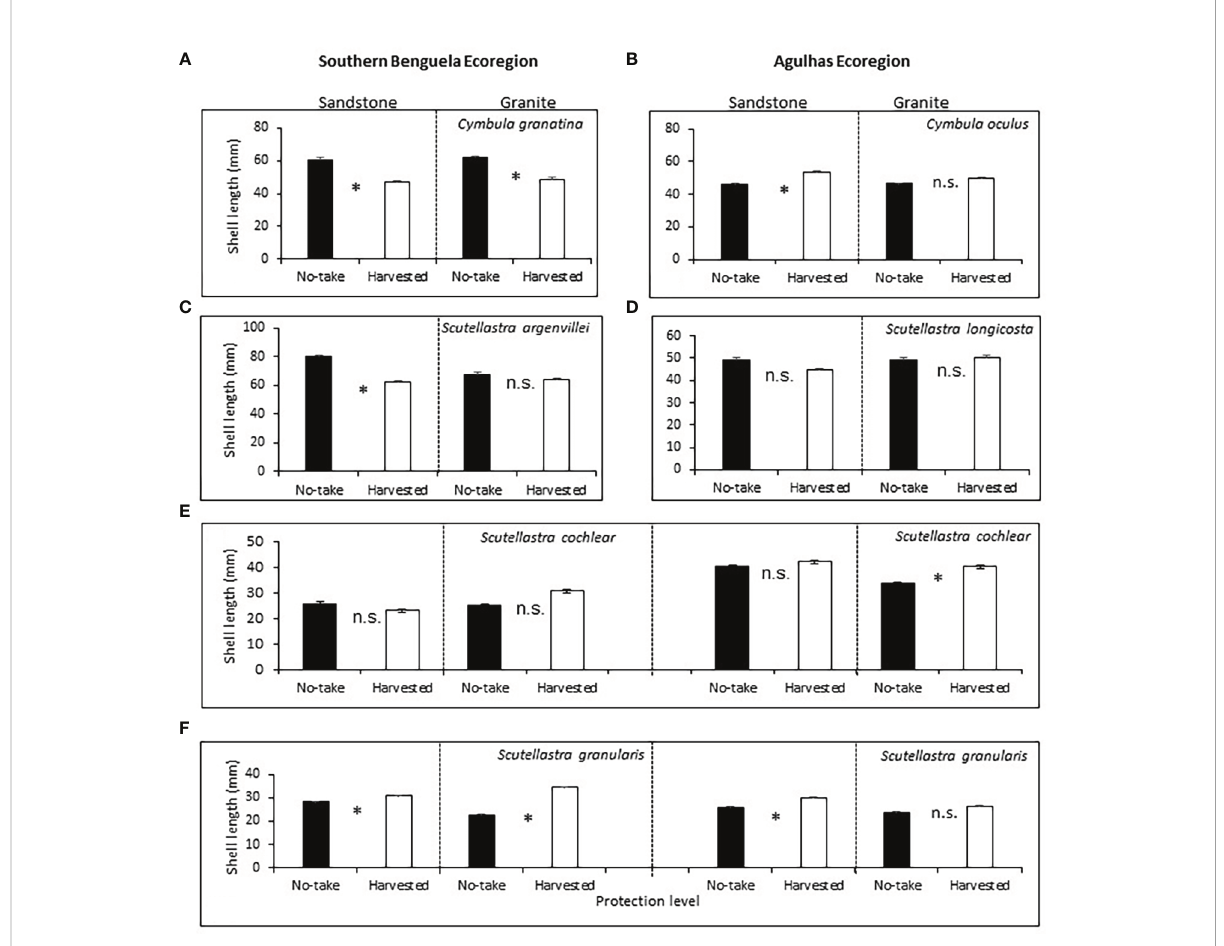
FIGURE 4 Mean shell lengths (+SE) of limpets, in relation to protection levels, rock types and ecoregions (in the case of species that occurred in both ecoregions). Asterisks between bars indicate Bonferroni-corrected signi fi cant differences. For further details see caption to Figure